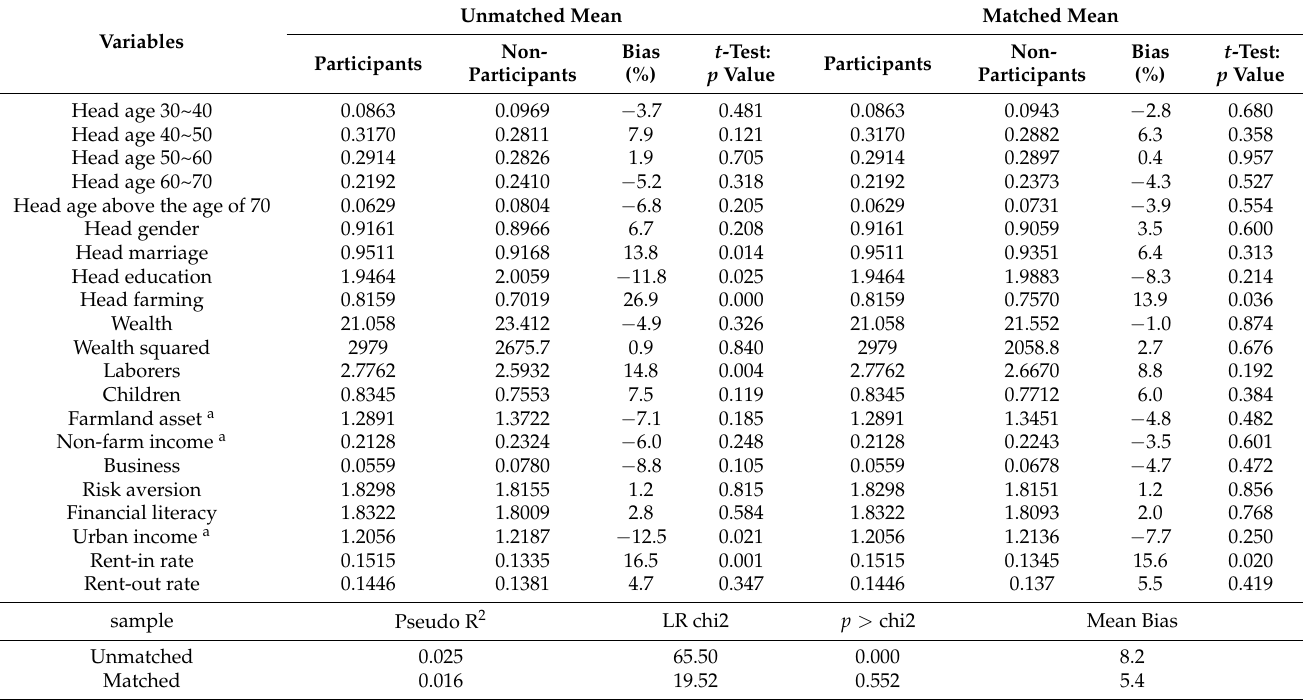
Table 4. Quality of the matching procedure.